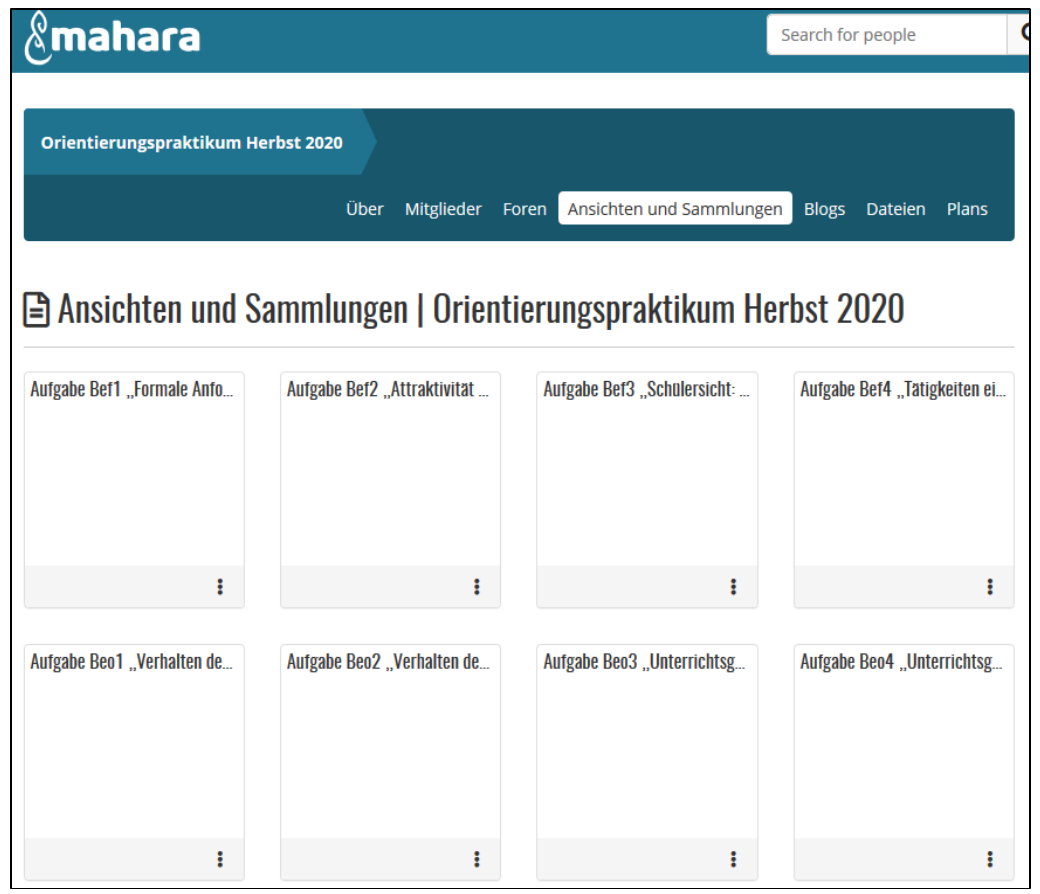
Figure 2: Templates for reflective tasks. Each page contains one reflective